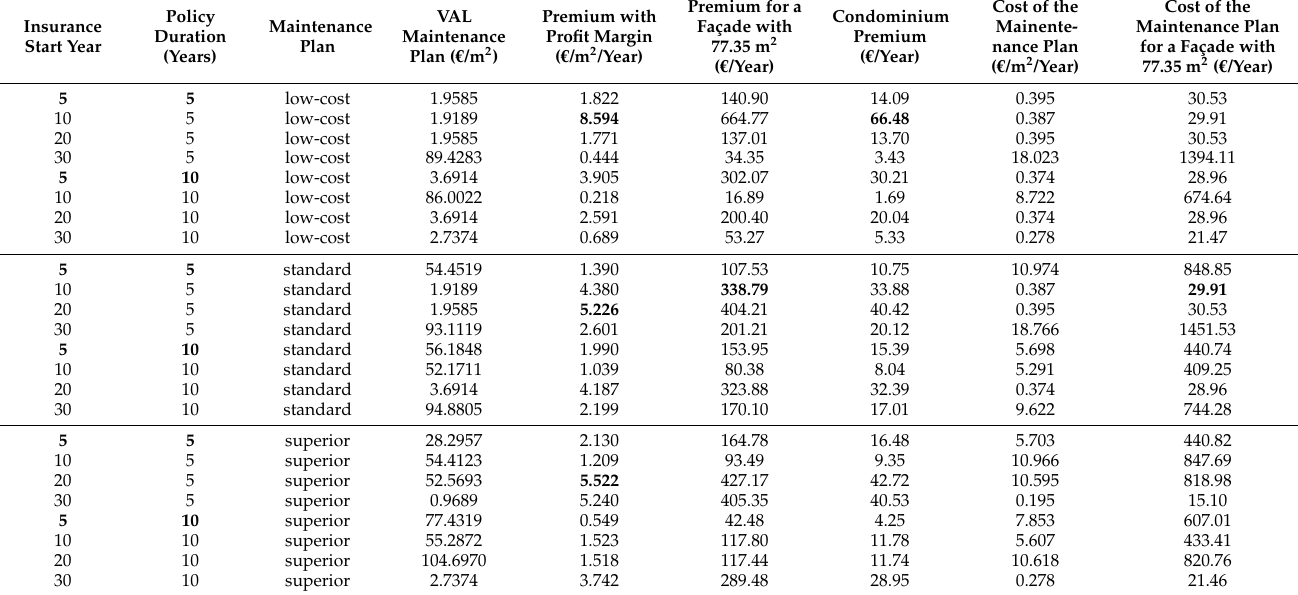
Table 10. Insurance policies for